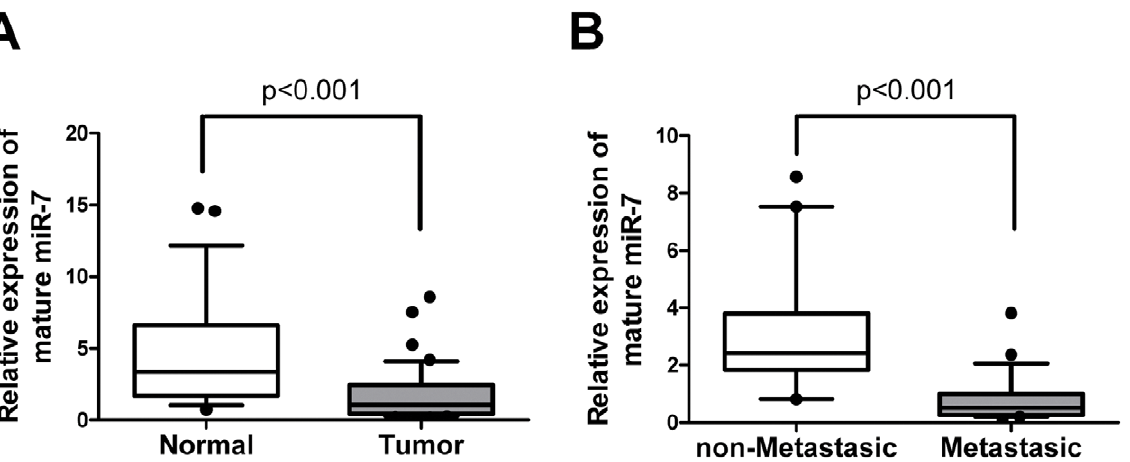
Figure 1. miR-7 expression is decreased in breast cancer and is associated with tumor metastasis. (A) The expression level of mature miR-7 in breast cancer (n=42) or normal breast tissues (n=27) was determined using quantitative PCR. Both breast cancer and normal breast are fresh tissues. Box-plot lines represent medians and interquartile ranges of the normalized threshold values; whiskers and spots indicate 10–90 percentiles and the remaining data points. (B) The relative expression of mature miR-7 in 19 non-metastatic breast cancer tissue and 23 metastatic breast cancer tissue samples. The expression level of mature miR-7 is normalized to U6 small nuclear RNA.